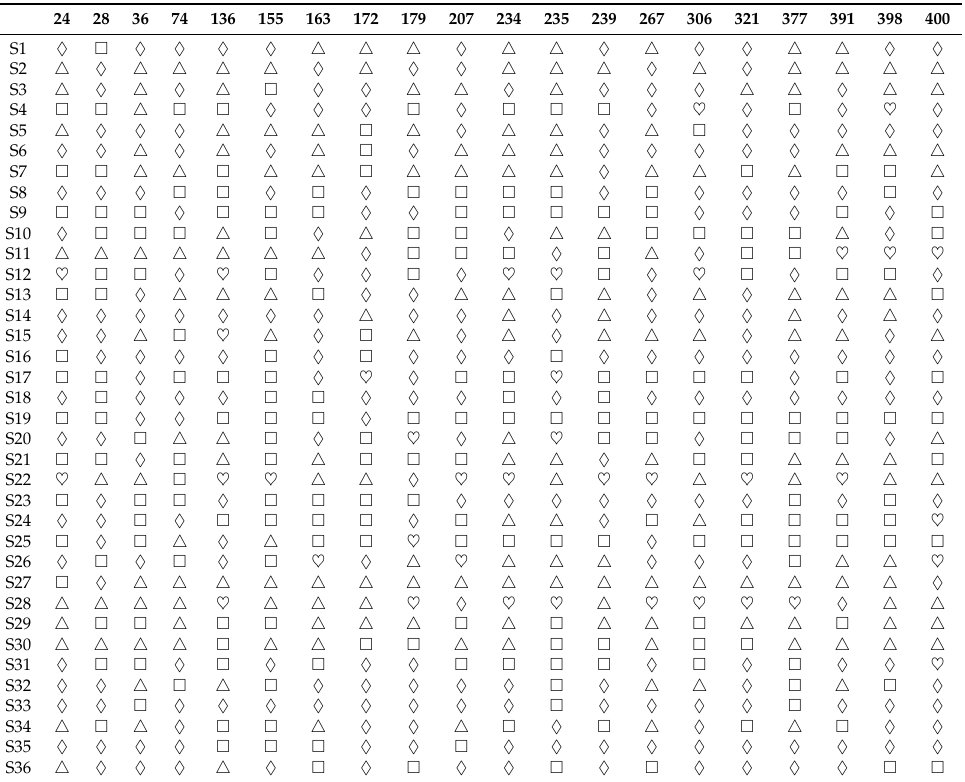
Table 5. Original questionnaire of subjective test.